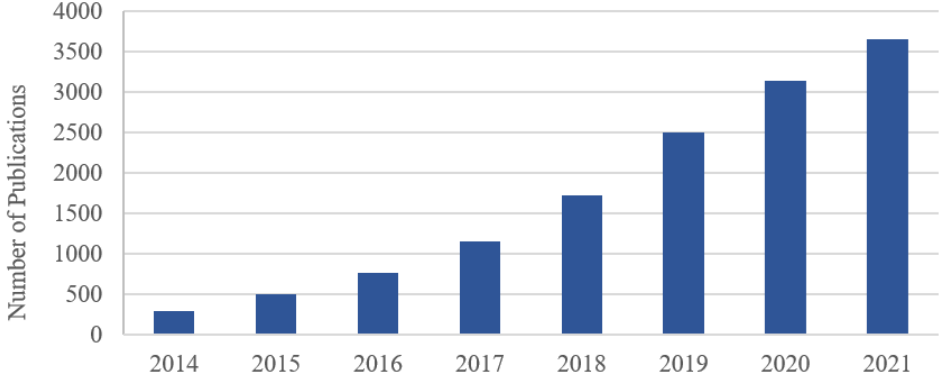
Figure 2. Number of relevant publications between 2014 and 2021.